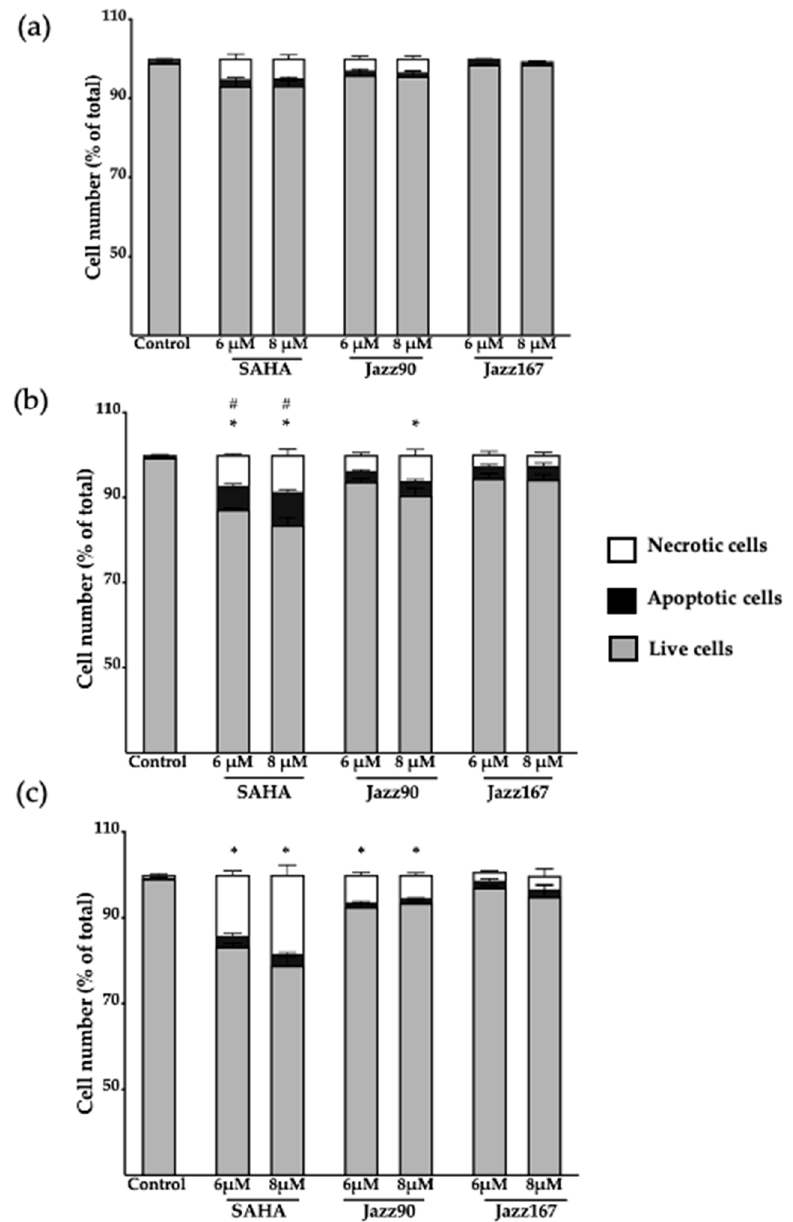
Figure 10. Analysis of apoptosis and necrosis in PC3 cells. Cells were treated with SAHA, Jazz90 and Jazz167 at concentrations of 6 and 8 µM. Vehicle control cells were treated with 0.5% DMSO. Cells were harvested at ( a ) 24, ( b ) 48, and ( c ) 60 h, after which the cells were stained with Annexin V and PI, and analyzed by flow cytometry. Bars represent the mean proportion of live, apoptotic and necrotic cells ± S.E.M. from three independent experiments. Data were analyzed using a two-way ANOVA coupled with Bonferroni’s post hoc test; * indicates significant differences in necrotic cells relative to the control, p < 0.05; # indicates significant differences in apoptotic cells relative to the control, p < 0.05.